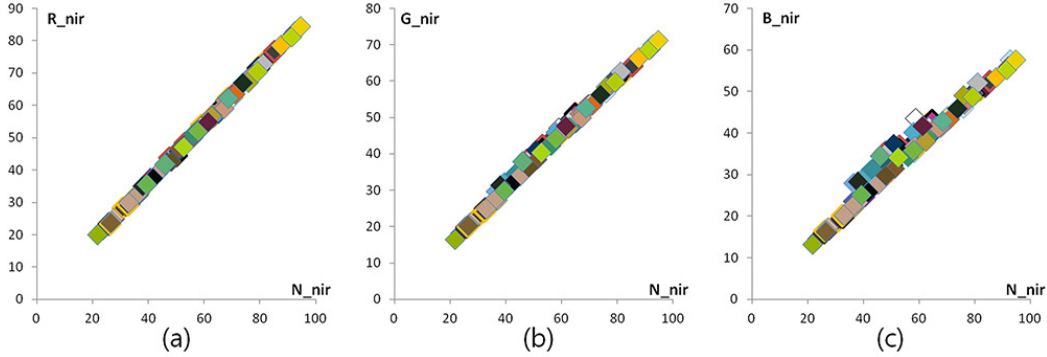
Figure 10. RGBN channel correlation in the NIR band: ( a ) N nir vs. R nir ; ( b ) N nir vs. G nir ; ( c ) N nir vs. B nir